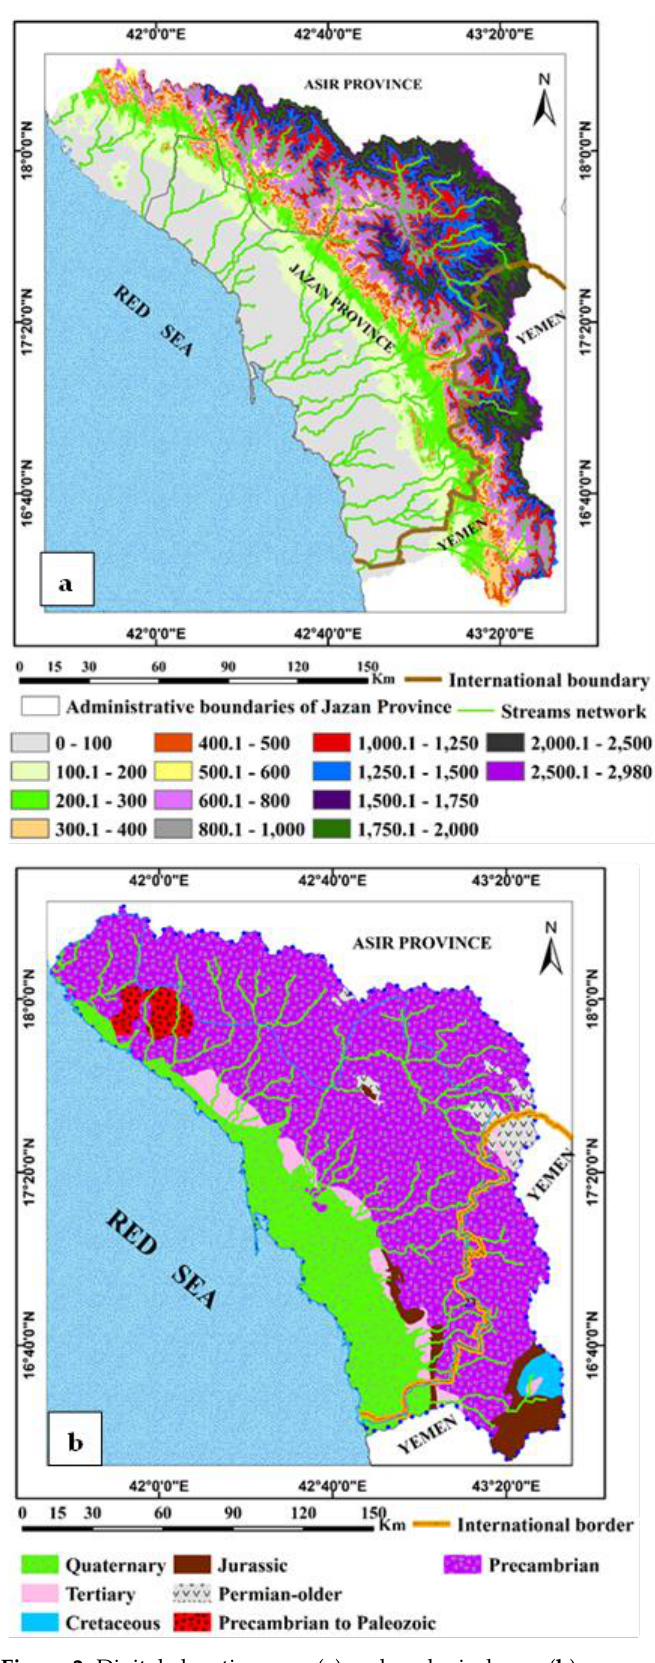
Figure 2. Digital elevation map ( a ) and geological map ( b ).